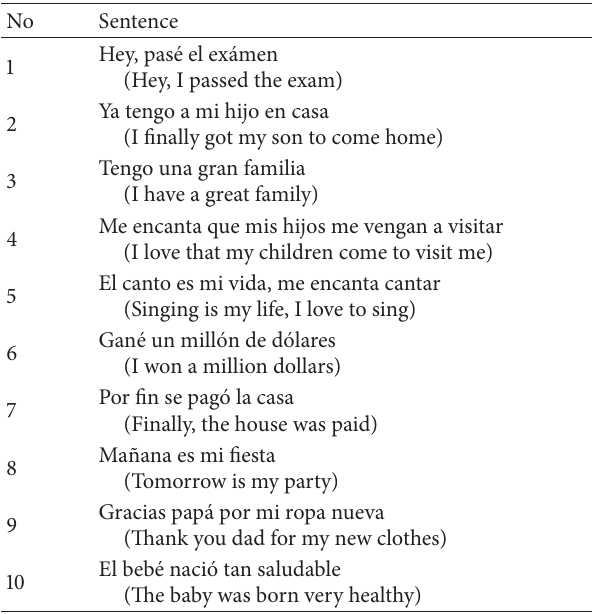
Table 4: Emotional stimuli: “tristeza” (sadness).